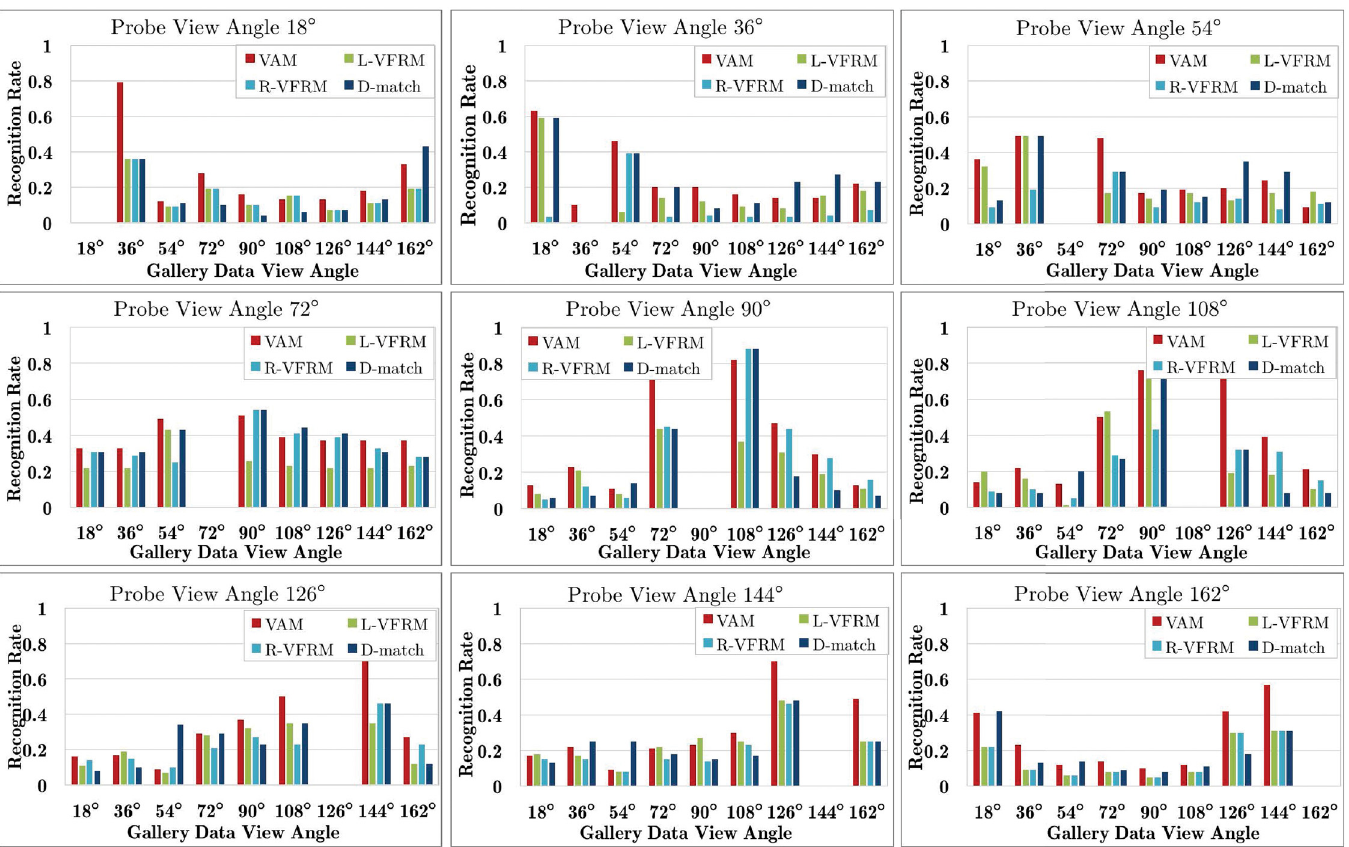
Fig 10. Results of free-view gait recognition where only one view (i.e., marked in the x-coordinate) is kept while the probe view and 50% data of the other views are missing in the training and gallery sets of